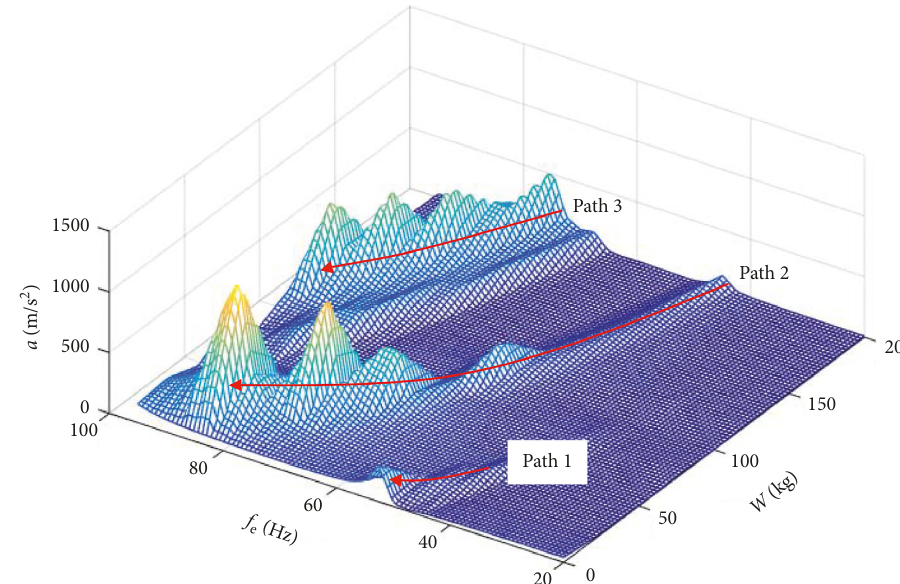
Figure 8: Changing regularity of the dynamic response with the load weight and excitation frequency.